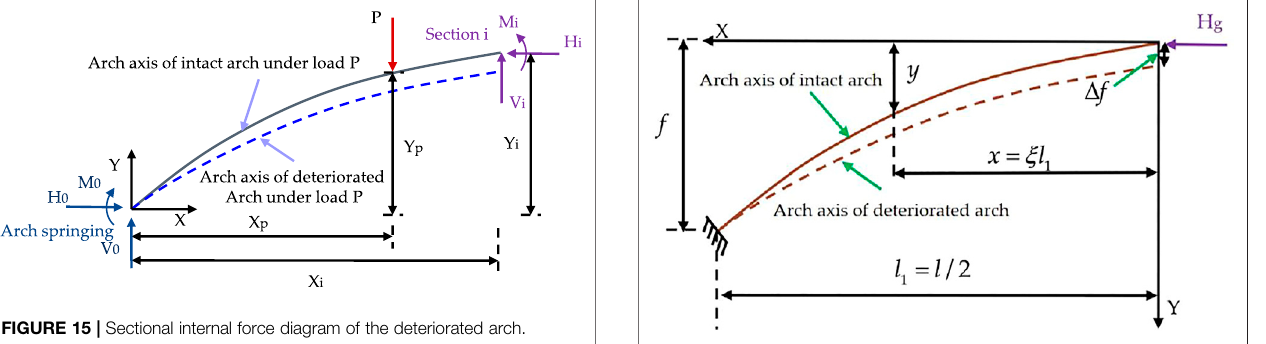
FIGURE 16 | Calculation diagram of a catenary arch.